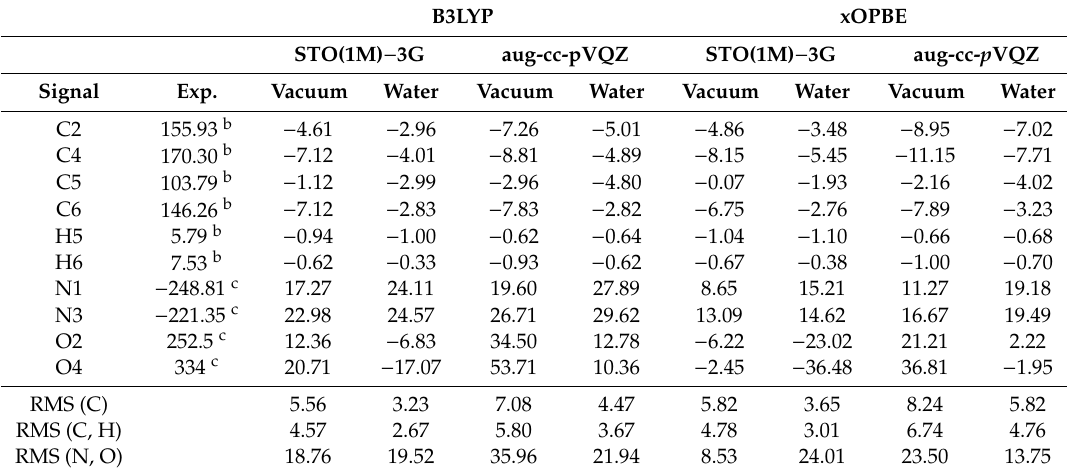
Table 3. Deviations from experiment of B3LYP and xOPBE calculated chemical shifts (in ppm) with STO(1M) − 3G and aug-cc-pVQZ basis sets for uracil tautomer 1 in the gas phase and water a . Separate RMS values for selected nuclei are shown.